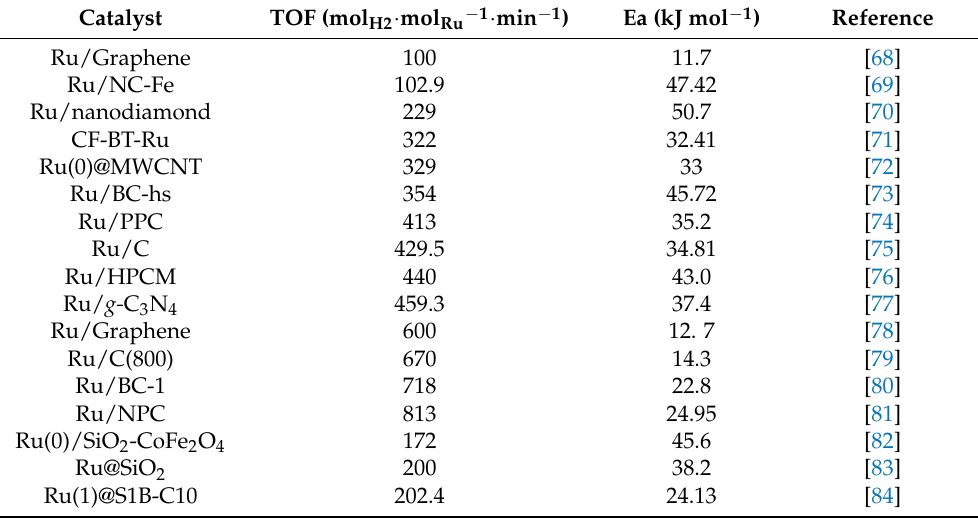
Table 2. Catalytic activity of heterogeneous Ru-based catalysts used for the hydrolytic dehydrogenation of ammonia borane (AB).